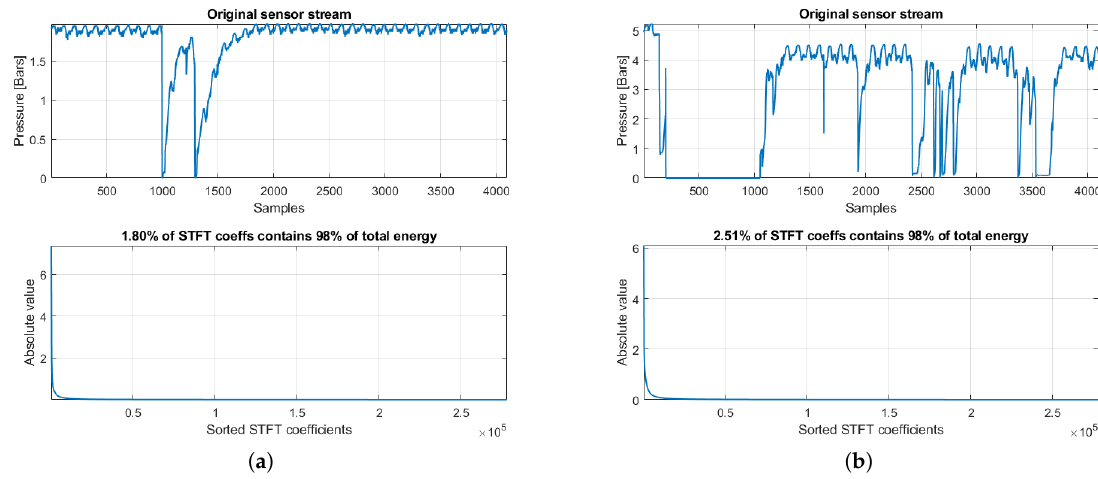
Figure 2. ( a ) Original pressure stream and sorted absolute STFT coefficients, under normal network conditions; and ( b ) original pressure stream and sorted absolute STFT coefficients, under abnormal network